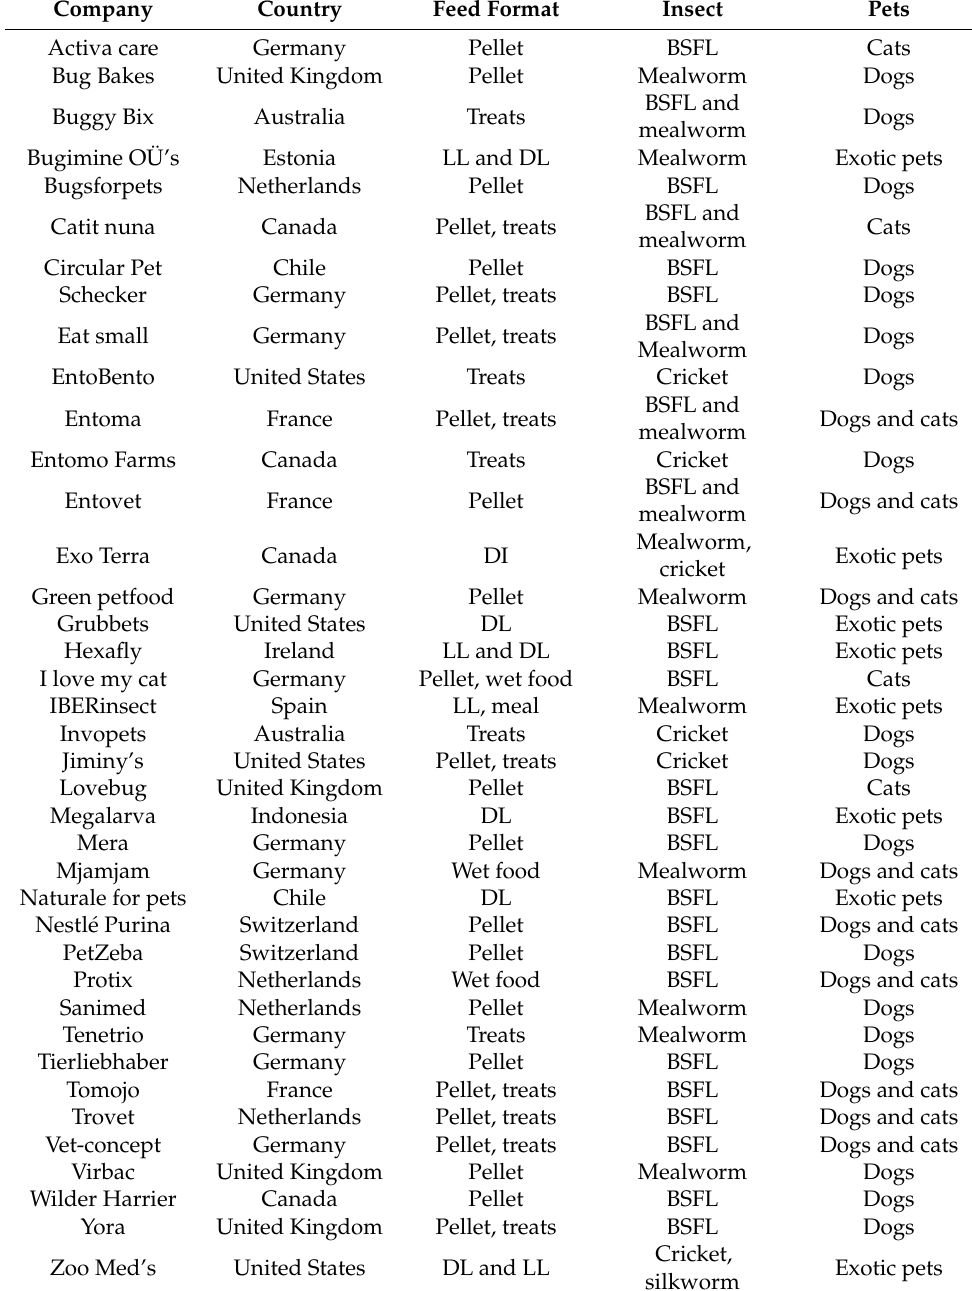
Table 2. Examples of pet foods that use